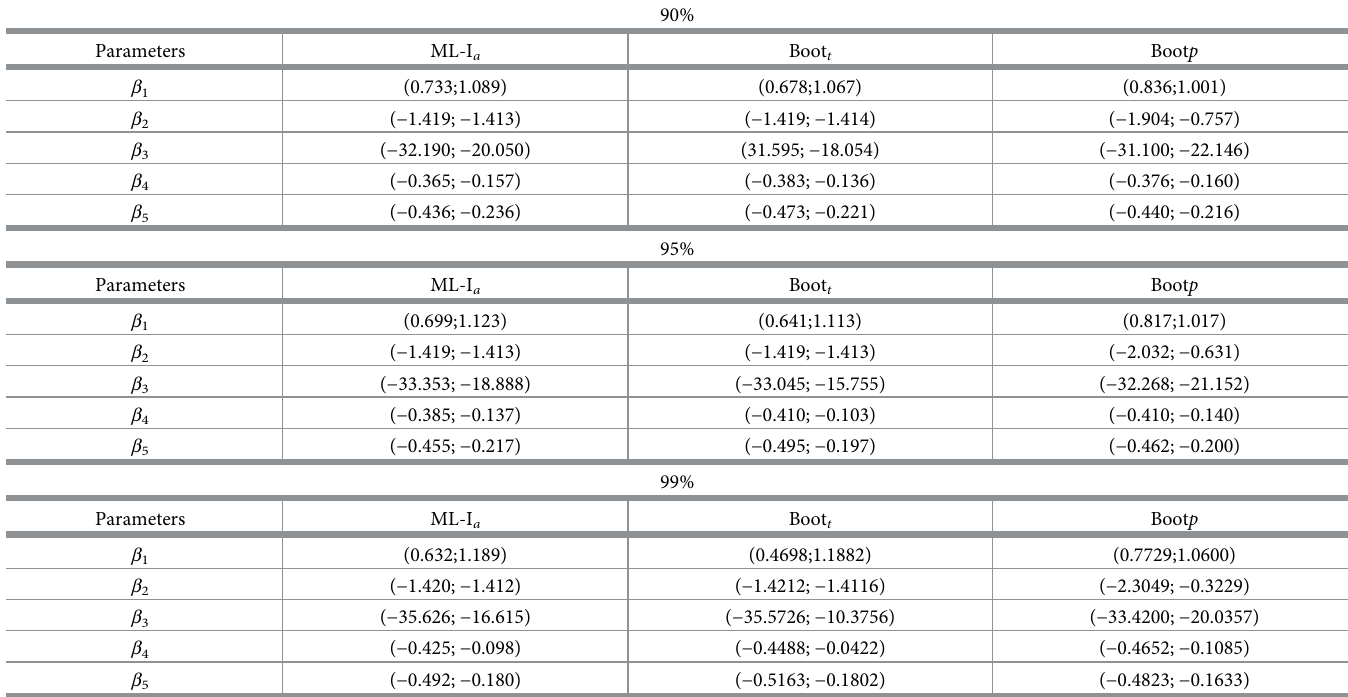
Table 12. ML-I a , Boot t and Boot p interval estimates for the parameters of Model-II. Fluid catalytic cracking (FCC)